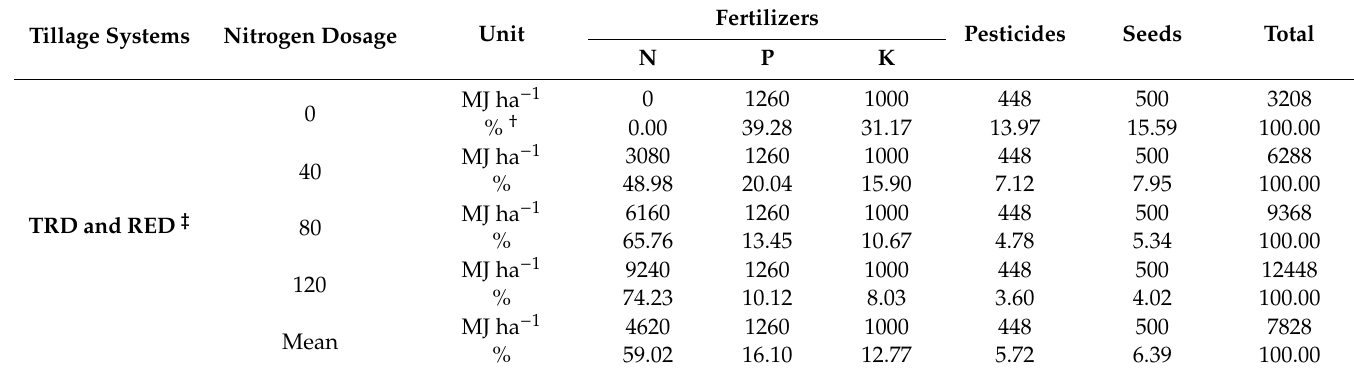
Table 4. Structure of the energy inputs in the raw materials and materials in the production of spring-Triticale. Tillage